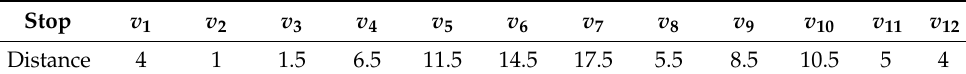
Table 1. Distance between the bus station and each stop (km).